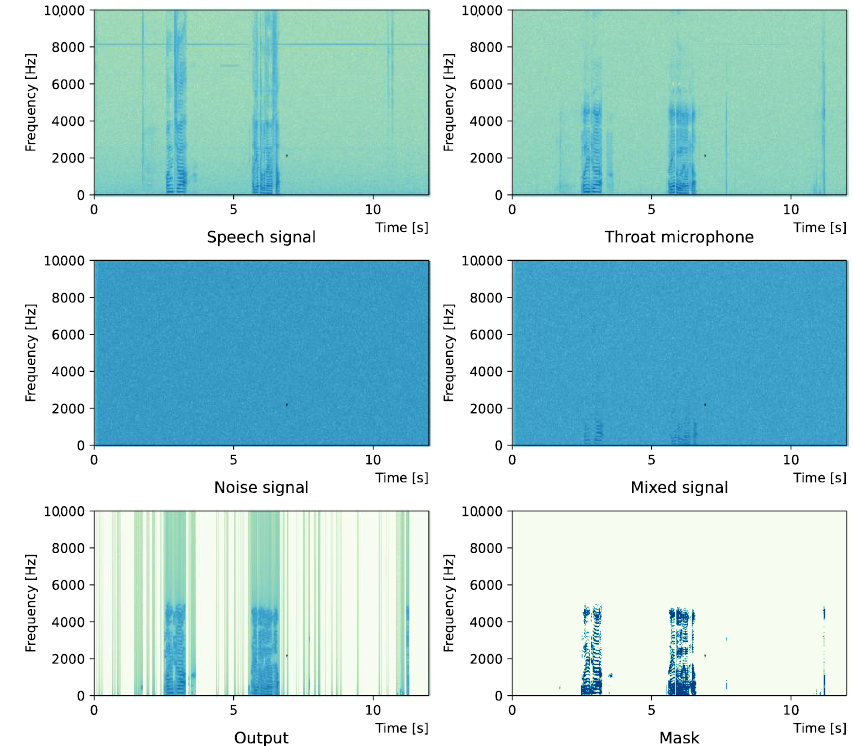
Figure 7. Spectrogram (White noise (−15 dB)).